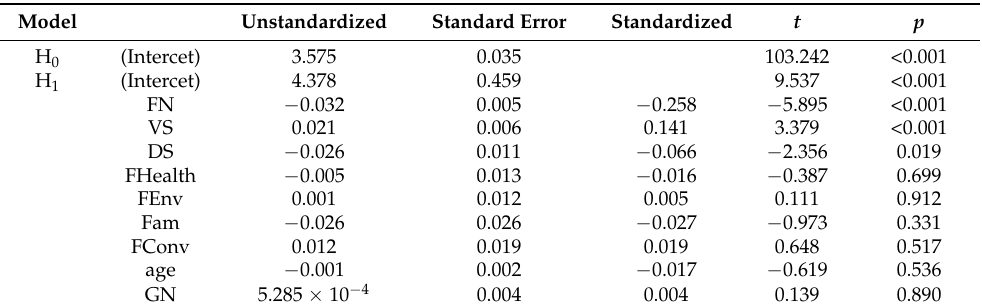
Table 4. Results of multiple regression model explaining consumers’ willingness to eat foods with